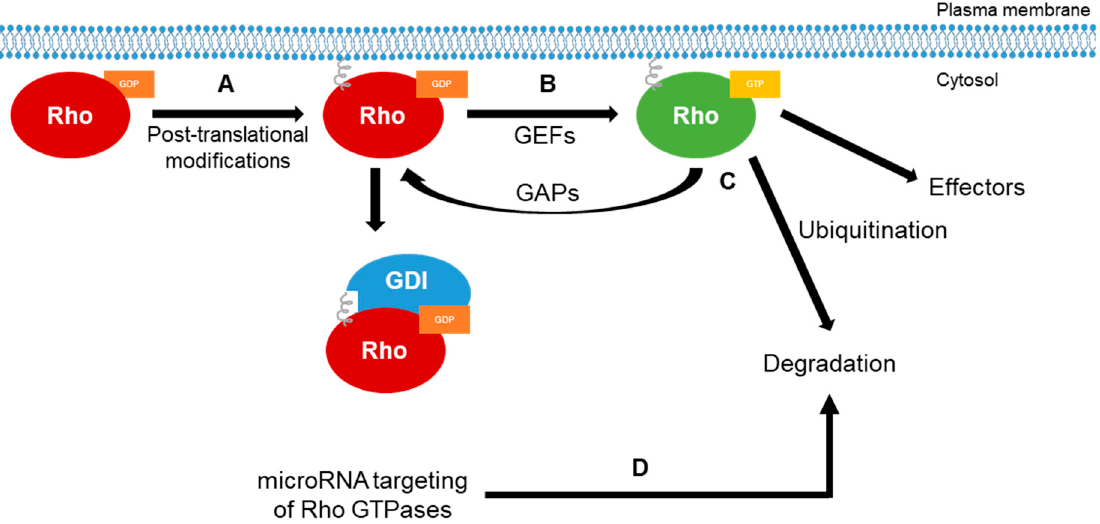
Figure 2. Regulation of Rho GTPases. ( A ) Newly synthesized Rho GTPases are post-translationally modified (such as prenylation and palmitoylation) on the C-terminus to be able to interact with the cellular or an organelle-specific membrane. ( B ) Once lipid modifications are added, Rho GTPases in the guanosine diphosphate (GDP)-bound state (“off” state) can interact with guanine nucleotide exchange factors (GEFs), which facilitate the exchange of GDP for guanosine triphosphate (GTP) and activate the Rho GTPases, or they can also interact with GDP dissociation inhibitors (GDIs), which bind and sequester Rho GTPases in the “off” state. This not only keeps the Rho GTPases from becoming active, but can also protect them from degradation [17]. ( C ) In the GTP-bound conformation, Rho GTPases regulate intracellular signaling cascades through binding and activating downstream effector molecules. This signaling is terminated by the intrinsic GTPase enzymatic reaction, which catalyzes GTP to GDP, and is enhanced by the interaction with GTPase-activating proteins (GAPs). In addition, GTP-bound Rho GTPases can also be sent for degradation by C-terminal ubiquitination or through direct targeting by microRNAs ( D ), terminating signaling. It should be noted that miRNAs bind and negatively regulate Rho GTPase mRNA, decreasing global expression levels of Rho GTPases.